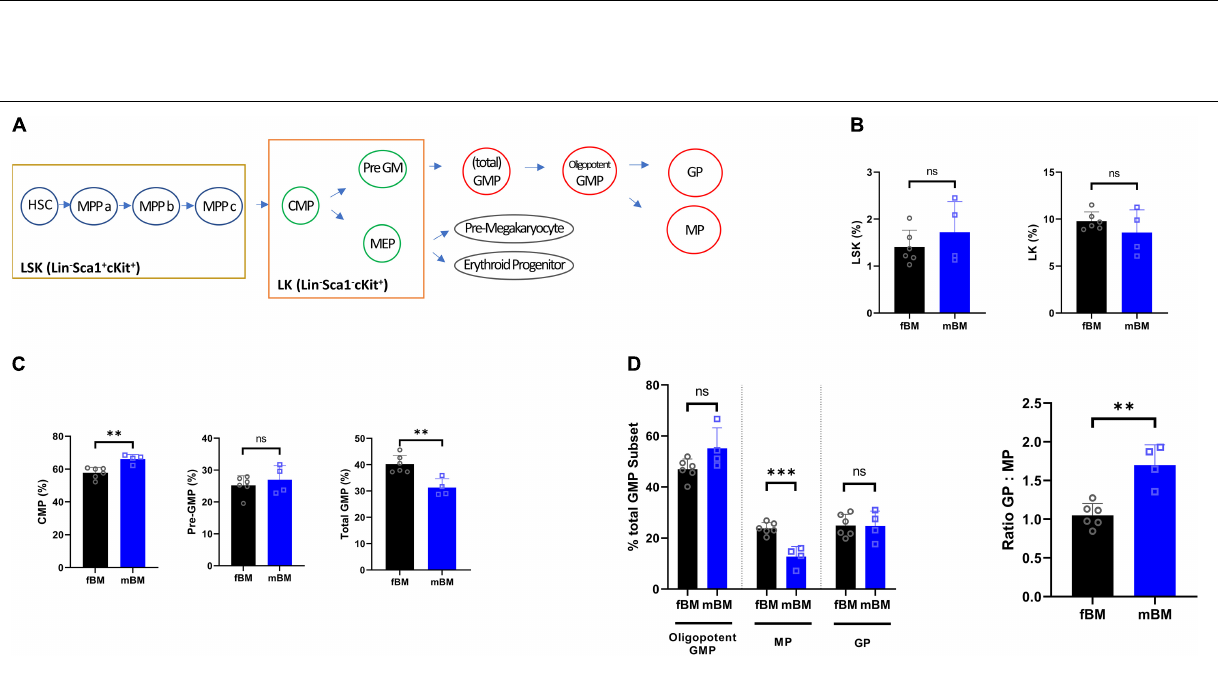
FIGURE 2 | Myeloid progenitors show a decrease in the total GMP population in mandibular bone. (A) Schematic view for mouse HSC hierarchy. (B) Percentages of LSK (Lin - Sca1 + cKit + ) or LK fractions (Lin - Sca1 - cKit + ) from the bone marrow of same subject-matched fBM and mBM. (C) Calculated frequencies of CMPs, Pre-GMPs, and total GMPs from bone marrow of same subject-matched fBM and mBM. (D) Percentage of GPs, MPs and oligopotent GMPs within the total GMP population (Left). Ratio of GP to MP in fBM and mBM (Right). Unpaired t test; data are presented as mean ± SEM of value from four independent experiments from fBM and mBM, ∗∗ P < 0.01, ∗∗∗ P <